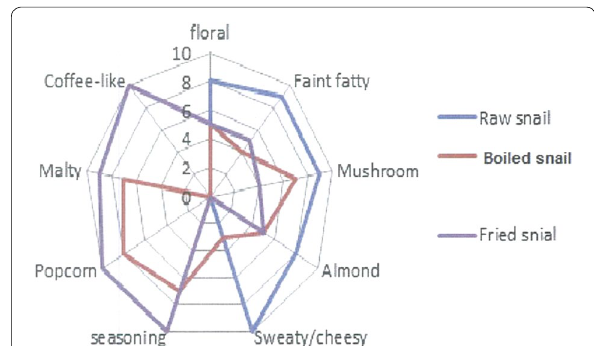
Fig. 3 Comparative aroma profiles of raw, boiled and fried snail meat